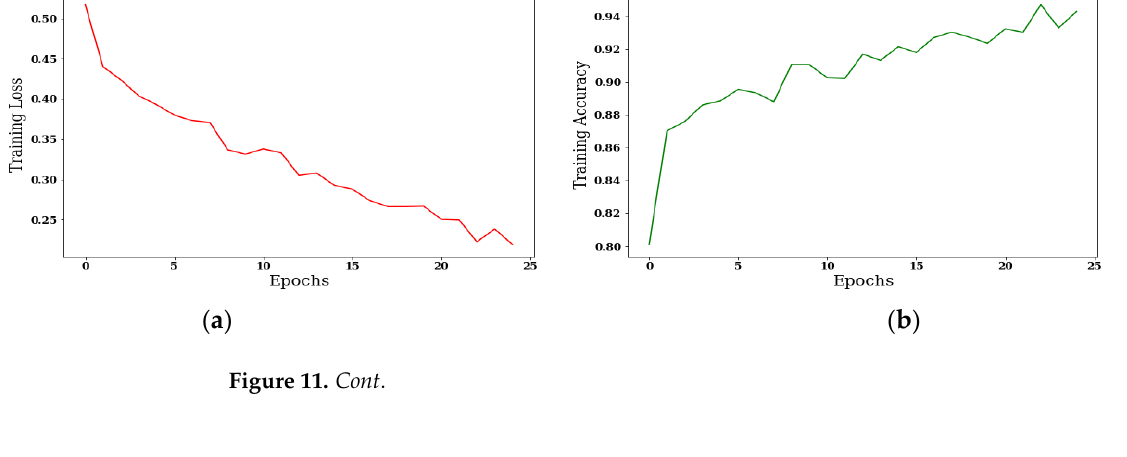
Figure 10. Analysis of confusion matrix parameters on different batch sizes.